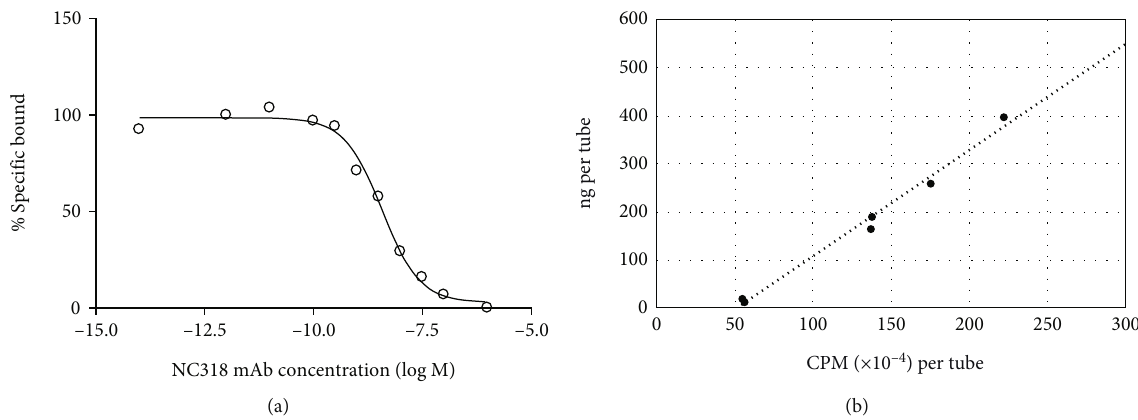
Figure 2: (a) Representative plot from an in vitro [ 89 Zr]Zr-DFO-NC318 saturation binding assay using 624-MEL+S15 cells with each point representing the average of duplicates; for this plot: K d = 3 : 14 ± 0 : 74 nM, B determined in the presence of 10 -6 M NC318; B MEL+S15, LOX IMIV, HCC-827, and 624-MEL WT cancer cell lines determined from in vitro saturation binding assays; each bar represents the mean ± SE ( n = 6 (624-MEL+S15), n = 4 (LOX IMIV), and n = 3 (624-MEL WT and